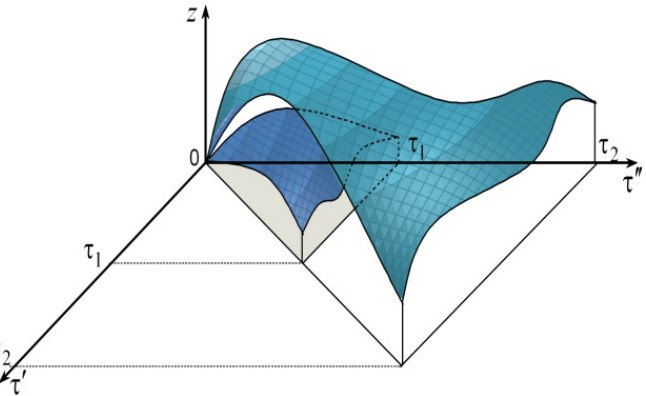
Figure 2. Schematic representation of the set of integrands in the space zO τ′′τ′ .